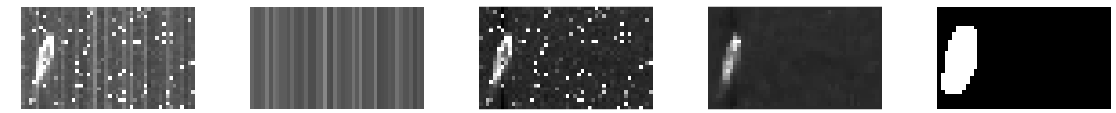
Figure 3. An example of the result of the compensation of readout DC and the detection of a stellar profile. From the left: original image, column medians, image after column compensation, outcome of the median filtering, and detected stellar